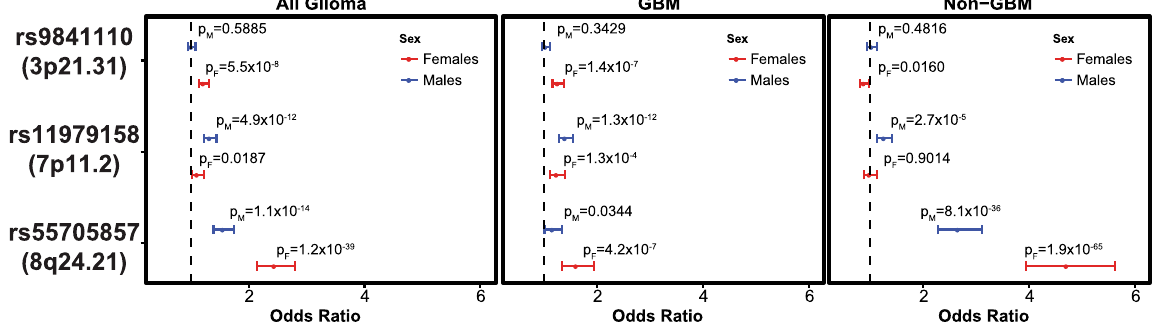
Figure 3. Sex-specific odds ratios overall and by histology grouping, 95% CI and p values for selected previous GWAS hits and 3p21.31 (rs9841110) for all glioma, GBM, and non-GBM.